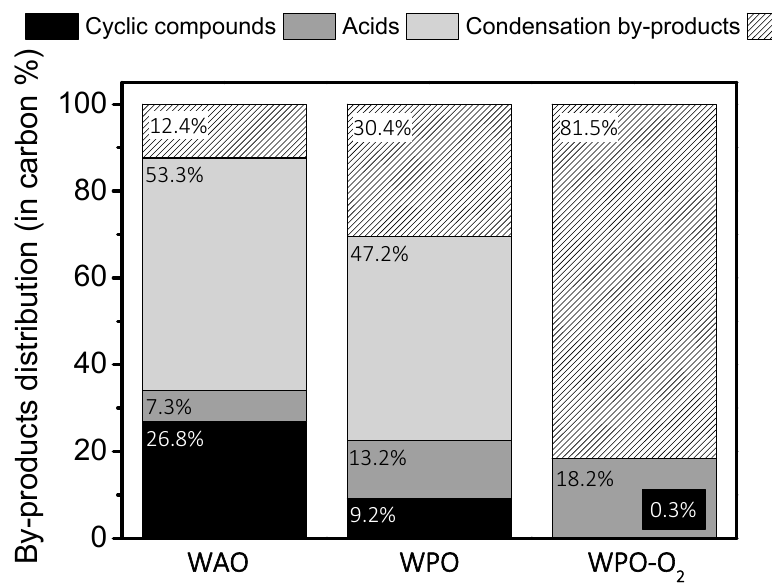
Figure 2. By-product distribution upon the WAO, WPO and WPO-O 2 of phenol after 3 h of reaction. Operating conditions: [Phenol] 0 = 1000 mg L − 1 , [H 2 O 2 ] 0 = 5000 mg L − 1 , P O2 = 8 bar (92 N mL O2 min − 1 ), T = 127 °C and natural pH 0 .